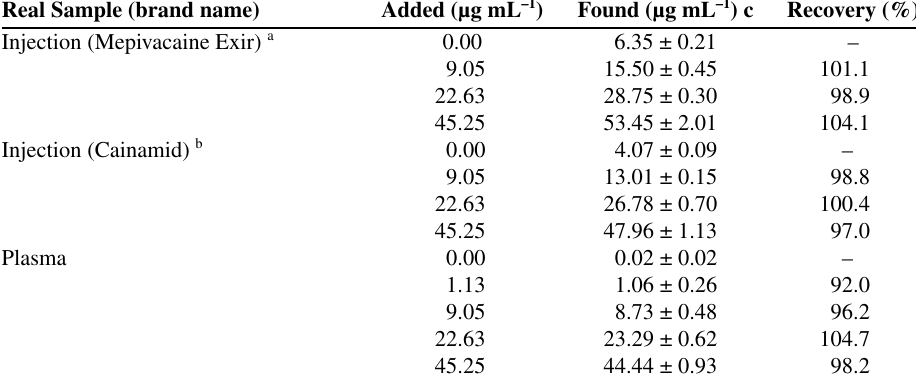
Table 2. Determination of mepivacaine in real samples